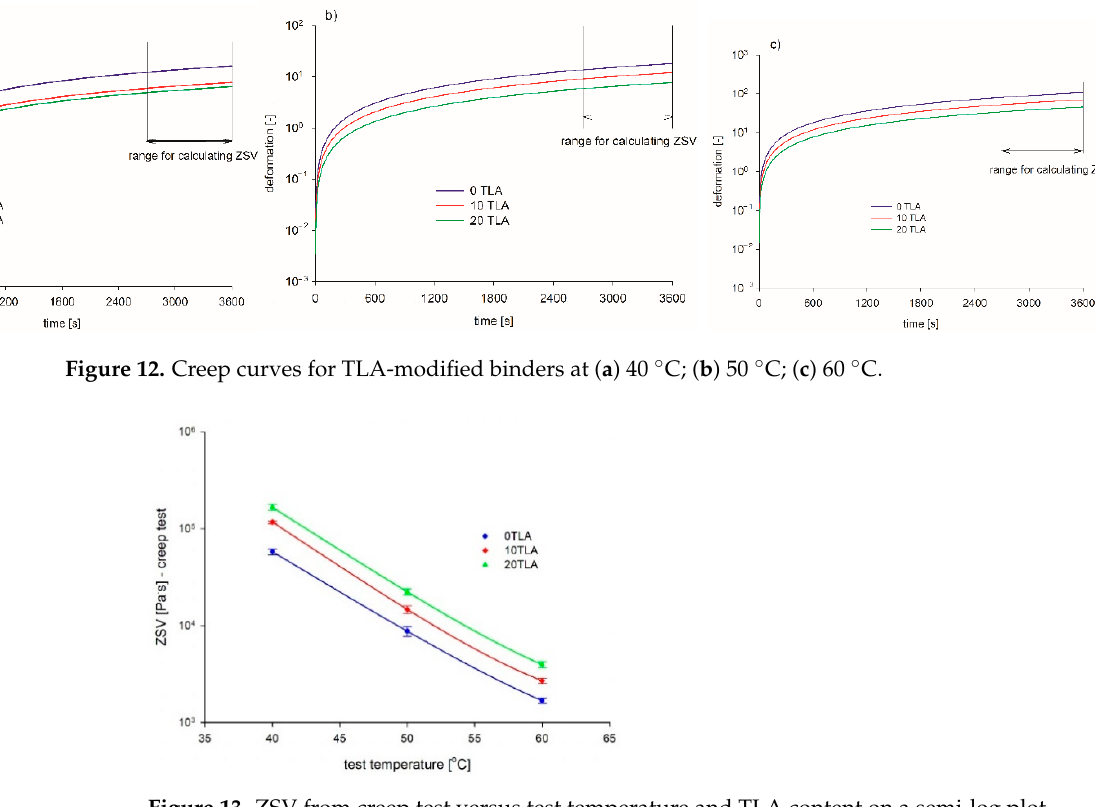
Figure 11. ZSV from the Cross model for various TLA content and test temperatures.